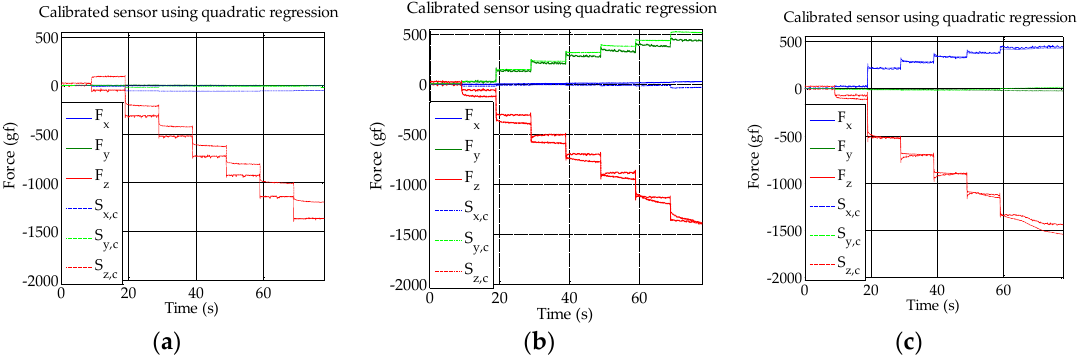
Figure 8. ( a ) Normal force; ( b ) 45-degree (y-axis direction); ( c ) 45-degree (x-axis direction) force calibration result. S x,c , S y,c and S z,c are the calibrated skin sensor measurements.